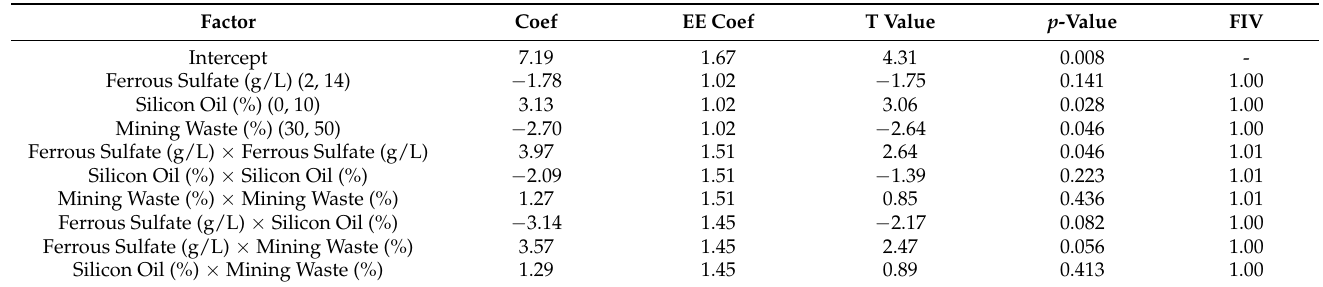
Note: The quadratic model shows a correlation coefficient of Table 2. Response surface regression coefficients: K laCO2 vs. ferrous sulfate, silicon oil, and mining waste (coded coefficients).